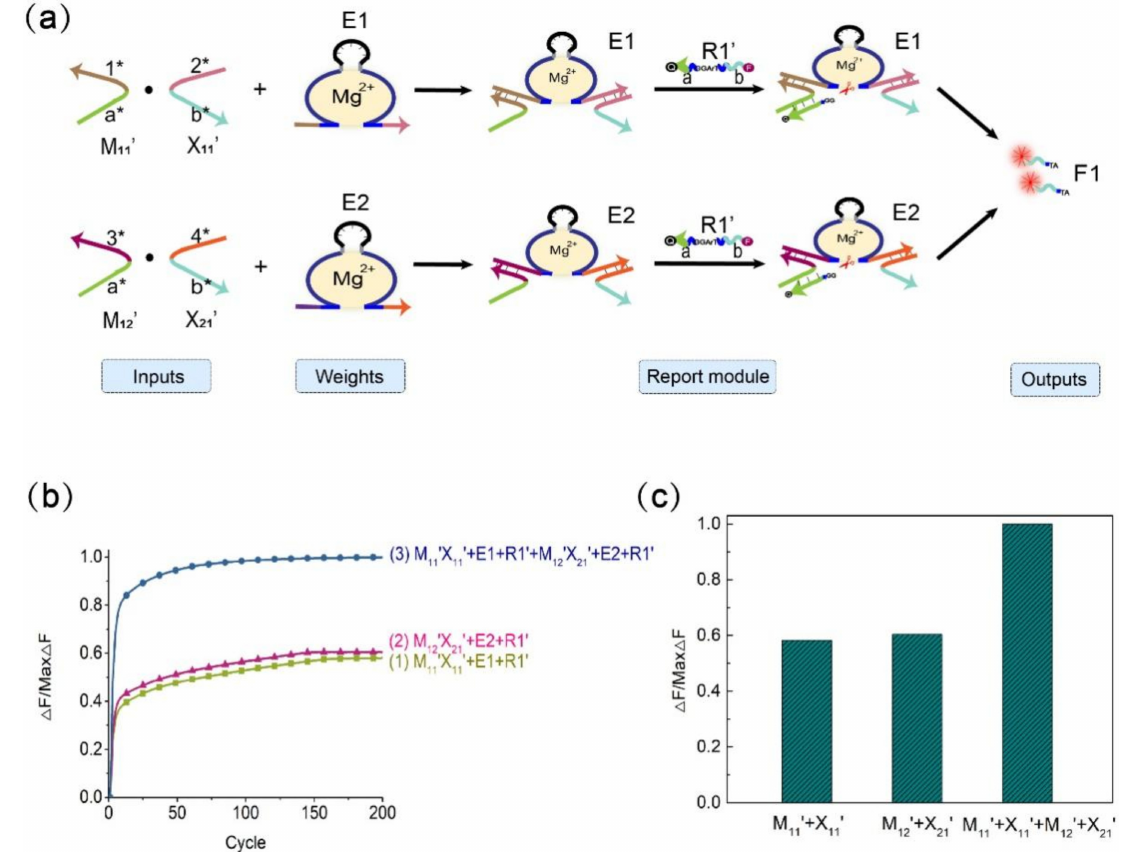
Figure 7. Schematic diagram of the matrix multiplication weighted sum. ( a ) Schematic diagram of the weighted sum process of the first-row value F1 of the output matrix F. ( b ) Normalized fluorescence image of F1. Curve (1), combination of M 11 (cid:48) X 11 (cid:48) and weight E1, substrate R1 (cid:48) , [M 11 (cid:48) ]:[X 11 (cid:48) ]: [E1]: [R1 (cid:48) ] = 1:1:1:2; curve (2), combination of M 12 (cid:48) X 21 (cid:48) and weight E2, substrate R1 (cid:48) , [M 12 (cid:48) ]:[X 21 (cid:48) ]: [E2]: [R1 (cid:48) ] = 1:1:1:2; curve (3), combinations M 11 (cid:48) X 11 (cid:48) , M 12 (cid:48) X 21 (cid:48) , weights E1, E2, and substrate R1 (cid:48) , [M 11 (cid:48) ]:[X 11 (cid:48) ]:[E1]:[M 12 (cid:48) ]:[X 21 (cid:48) ]:[E2]:[R1 (cid:48) ] = 1:1:1:1:1:1:2. ( c ) Histogram representation of F1. The sampling interval is 7 min, 200